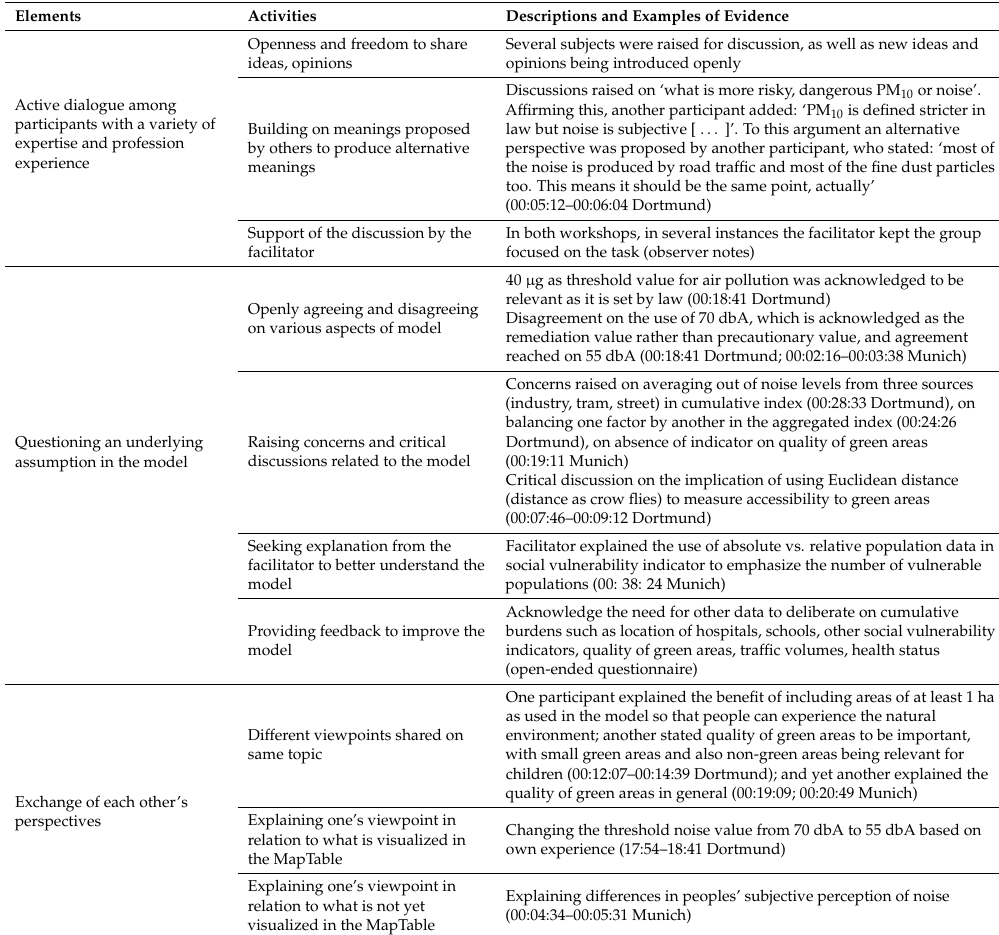
Table 2. Evidence of communication support provided by our interactive stakeholder-based CuBA approach.